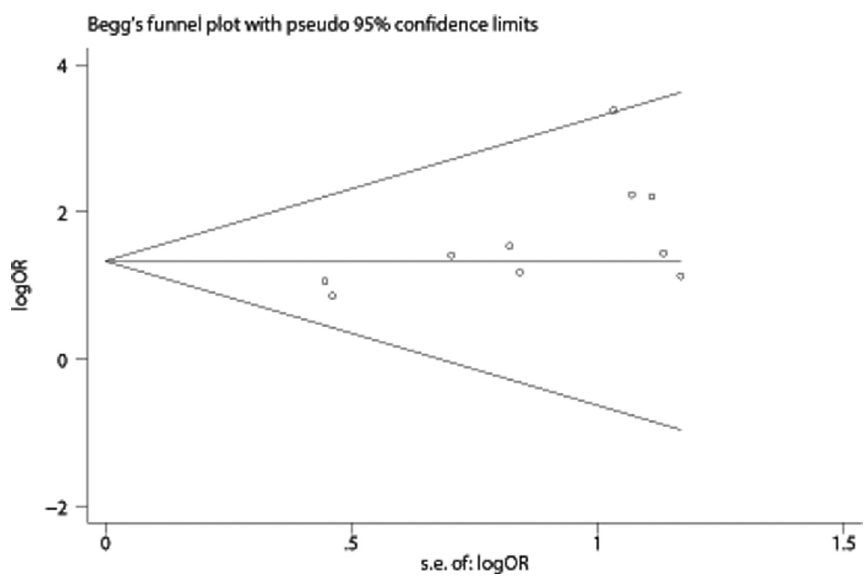
Figure 4. Funnel plots of the evaluation of potential publication bias in the efficacy of TCM nursing combined with conventional nursing in patients with COPD. COPD = chronic obstructive pulmonary disease; s.e. = standard error; TCM = traditional Chinese